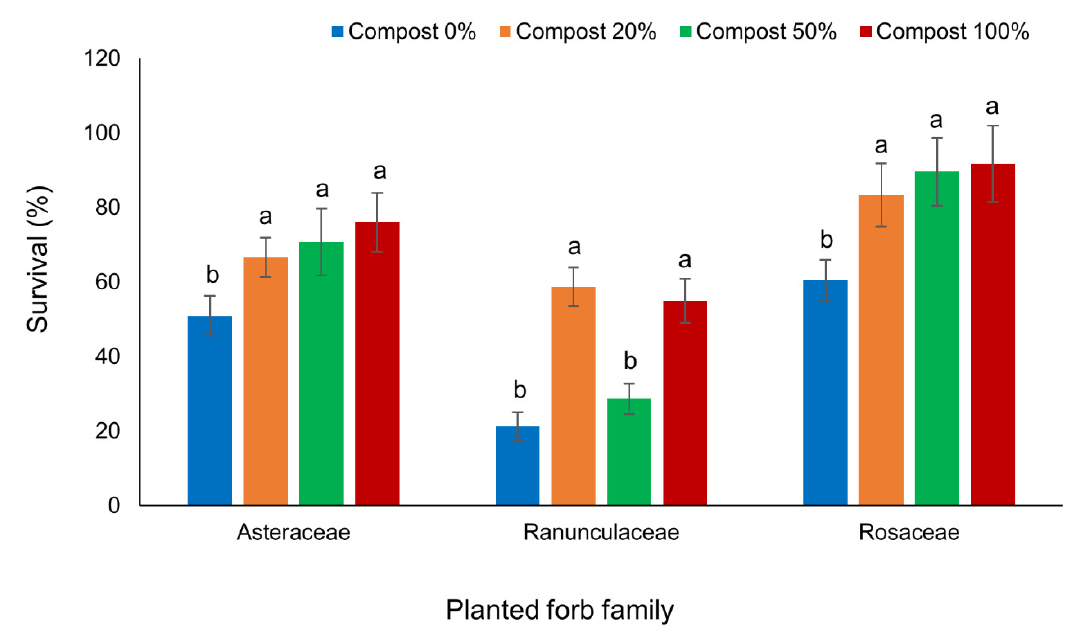
Figure 2. Mean (±SE) survival percent grouped by family and soil amendment. Different letters Figure 2. Mean ( ± SE) survival percent grouped by family and soil amendment. Different letters within species indicate significance differences at α = 0.05. within species indicate significance differences at α =